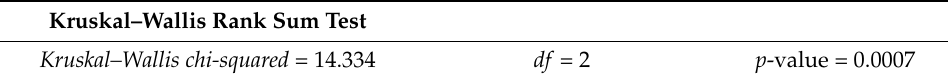
Table 4. Kruskal–Wallis